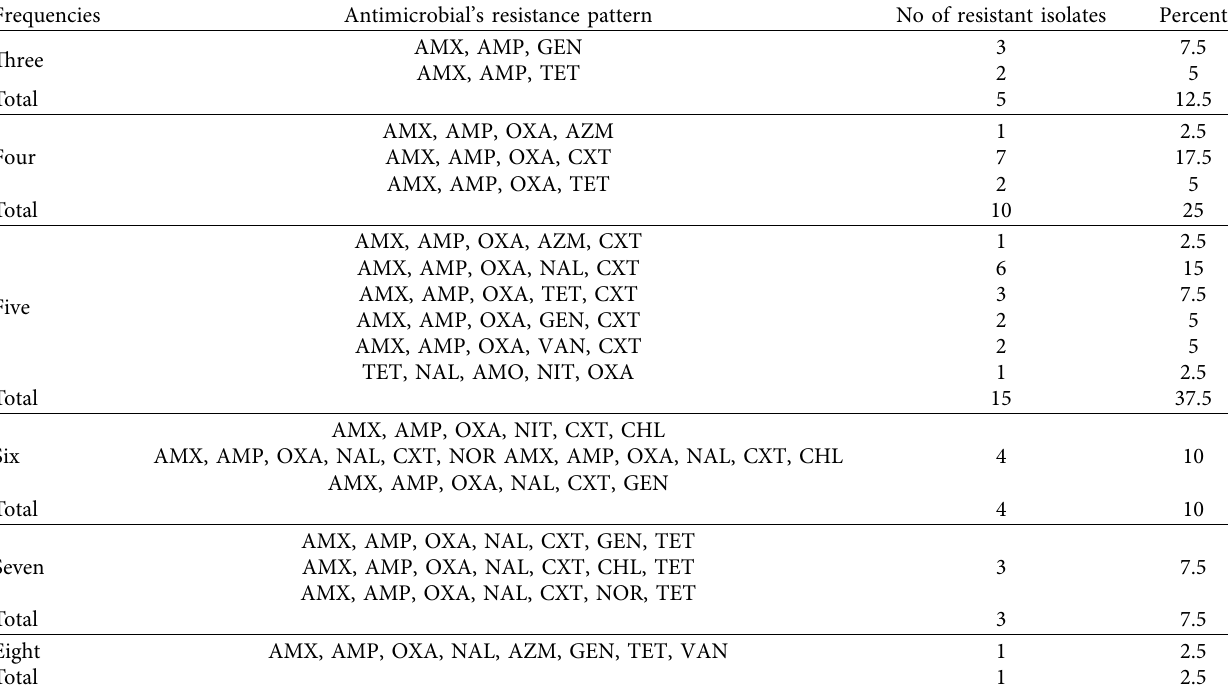
Table 8: Patterns of drug resistance of S. aureus isolated from milk and milk products. Frequencies Antimicrobial’s resistance